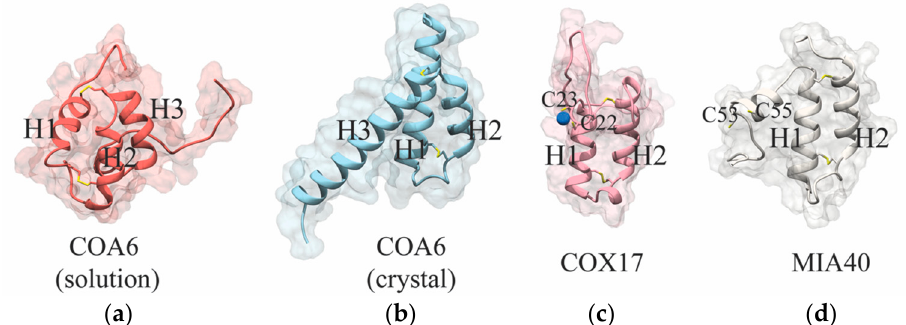
Figure 3. Comparison of the structure of COA6 with other human CHCH domain-containing proteins. The solution structure of COA6 (PDB 6NL3) ( a ) and a monomer from the crystal structure of dimeric COA6 (PDB 6PCE chain B) are shown ( b ). Solution structure of COX17 (PDB 2RNB) ( c ). Solution structure of human MIA40 (PDB 2K3J) ( d ). The cysteines that form the disulfide bonds in the CX 9 C-CX 9-10 C motif have been shown in sticks. The copper binding cysteines of COX17 ( c ) and the redox-active cysteines of MIA40 ( d ) have also been highlighted in sticks. Copper is shown as a blue sphere.